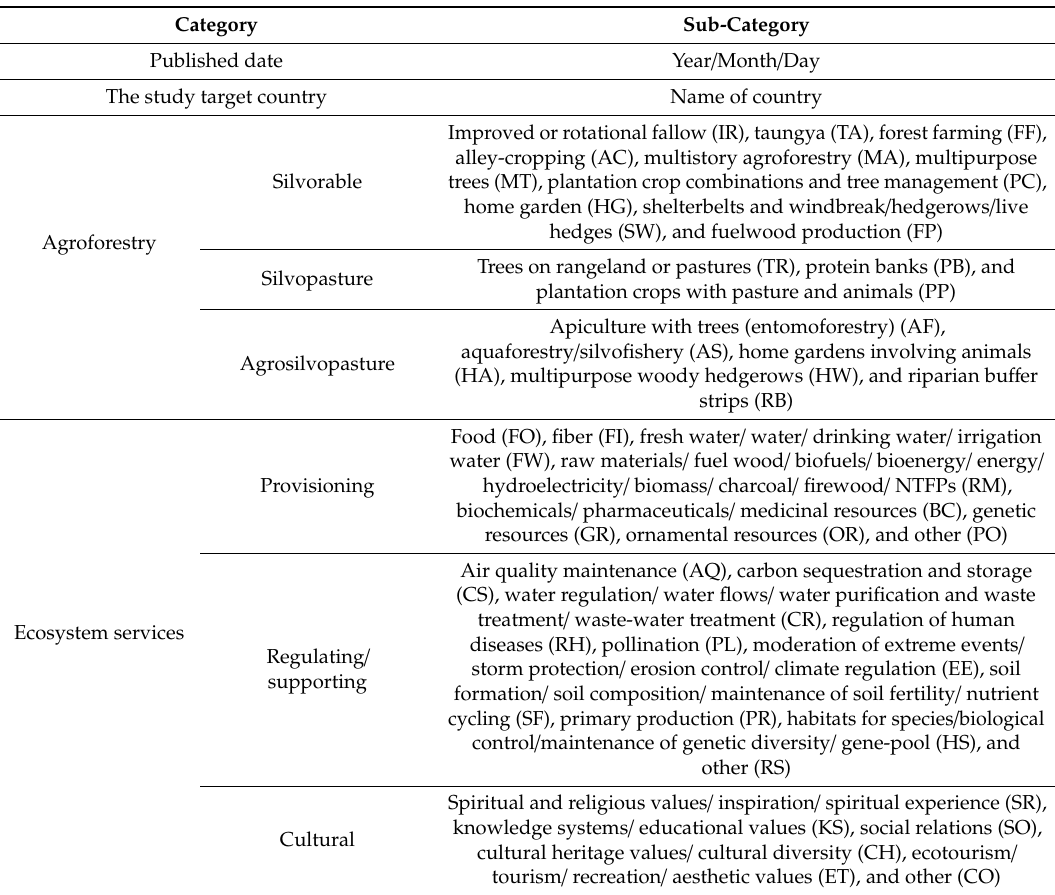
Table 3. Coding category system